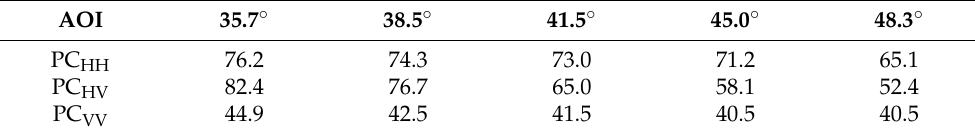
Table 3. Multi-polarisation PC metrics evaluated at the five AOIs.